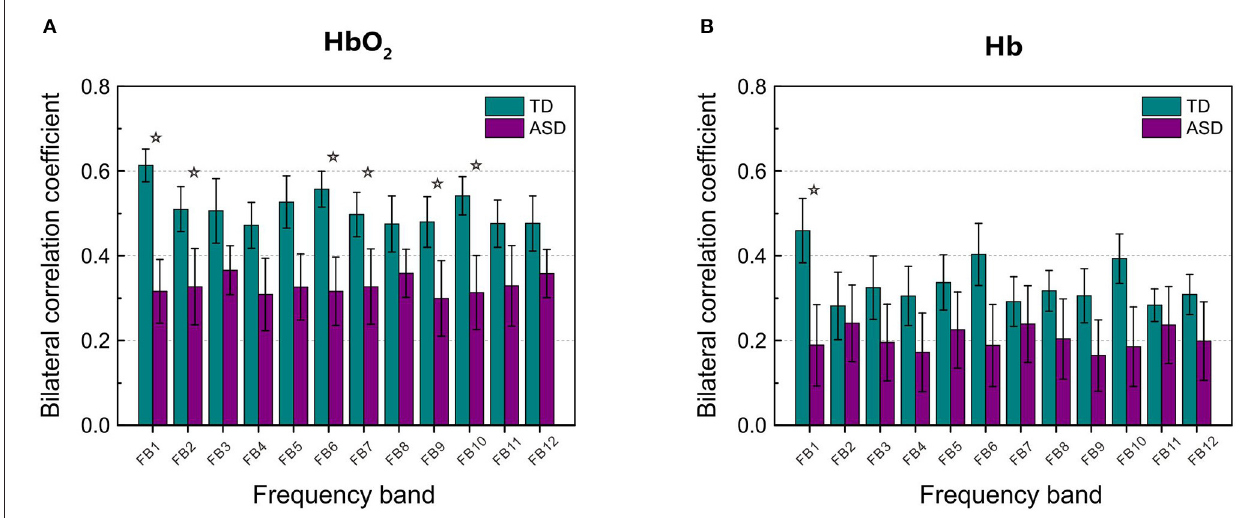
FIGURE 2 | The grand average of the correlation coefficients for HbO 2 (A) and Hb (B) between the left and right hemisphere in each frequency band (from FB1 to FB12, in total 12 bands) for TD and ASD groups. The asterisks indicate that the differences in the correlation coefficient between ASD and TD are statistically significant (FDR-corrected q < 0.05), and the statistical powers are larger than 0.8. FDR-corrected q values on HbO 2 are 0.0024, 0.0048, 0.0032, 0.0106, 0.0144, and 0.0048 for FB1, FB2, FB6, FB7, FB9, and FB10, respectively. FDR-corrected q value on Hb is 0.0116 for FB1. The error bar for each correlation coefficient is the standard error of mean.